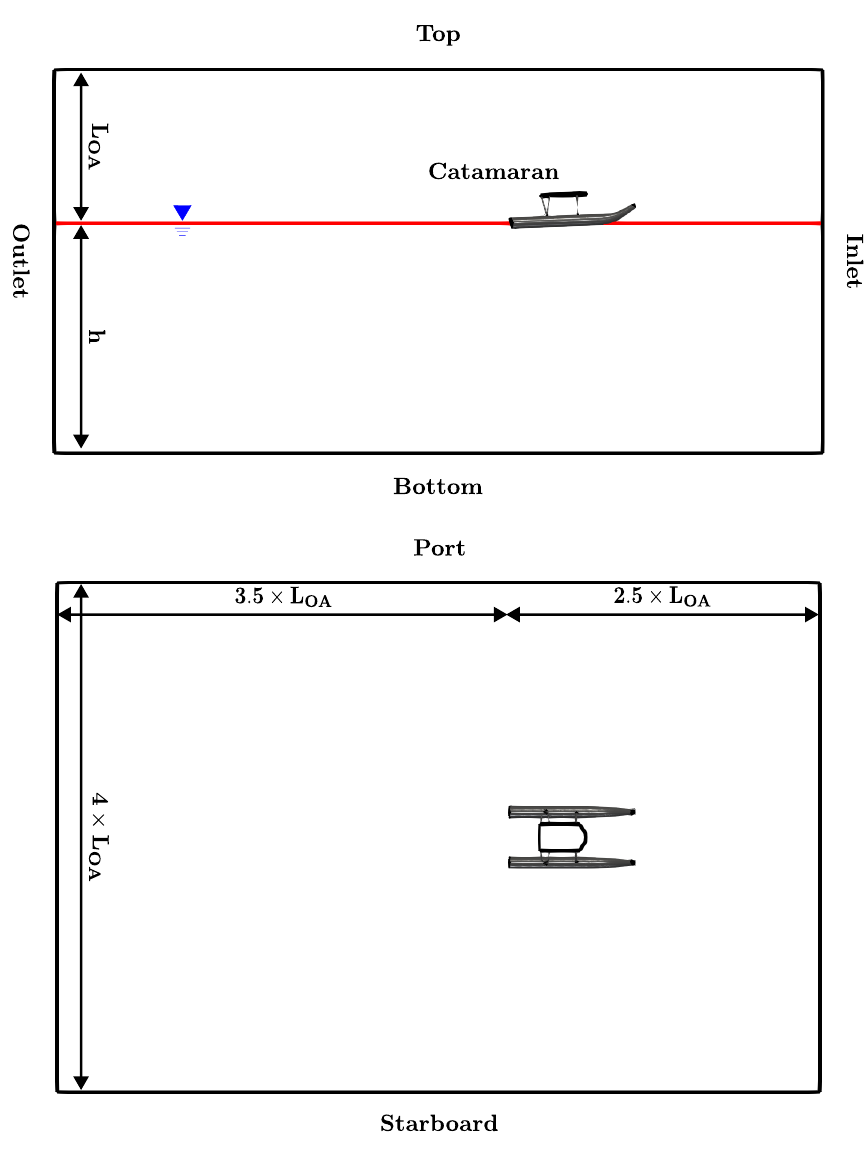
Figure 3. Computational domain and